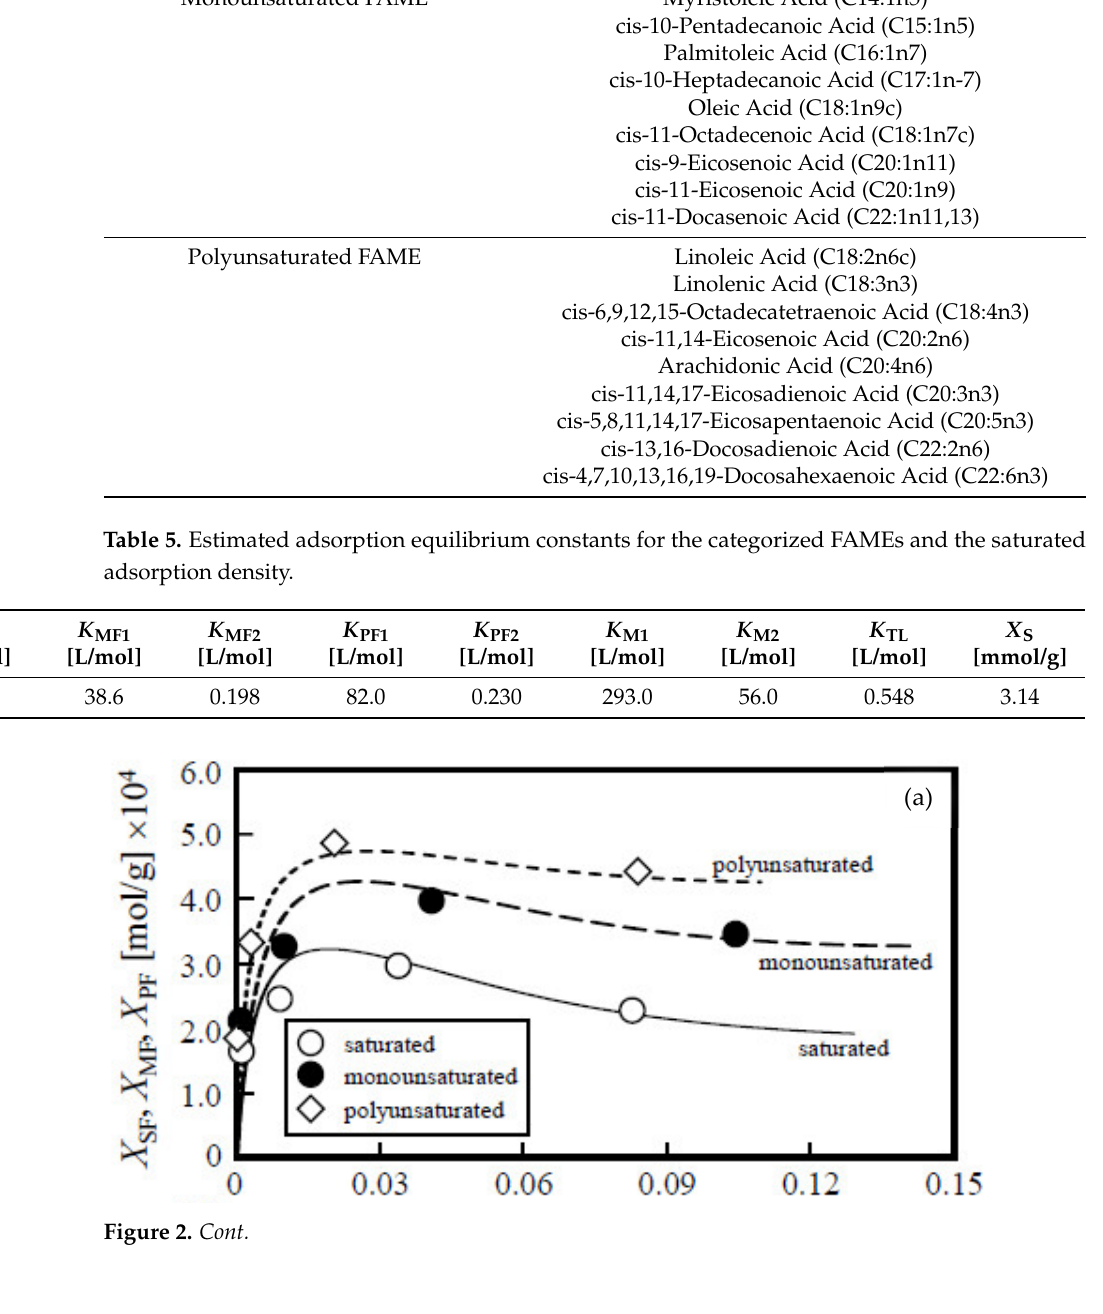
Figure 2. The adsorption isotherms: ( a ) SF, MF, and PF; ( b ) TL; ( c ) ME. The solid lines are values calculated using Equations (5)–(9) and the parameters in Table 5. 4. Conclusions The influence of coexisting substances on the adsorption behavior of FAME derived from squid liver, as a model substance of biodiesel fuel, onto a silica surface in the presence of methanol and toluene was investigated, assuming the adsorption of diesel fuel from the solution after the reaction in the biodiesel production